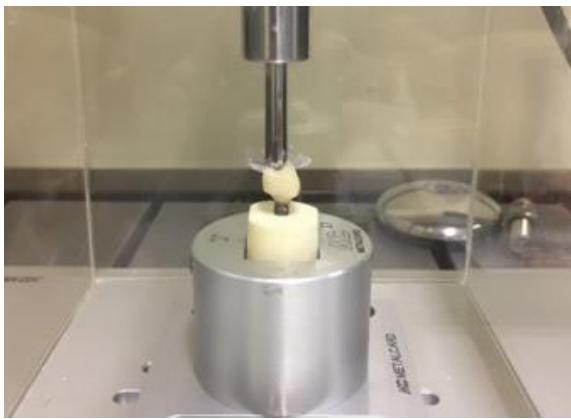
Figure 4. Sample positioned to perform the survival test.